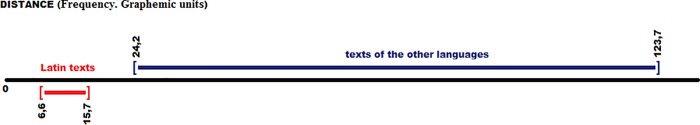
Distances between the Latin (average value) with all the texts in all the languages (graphemic units).